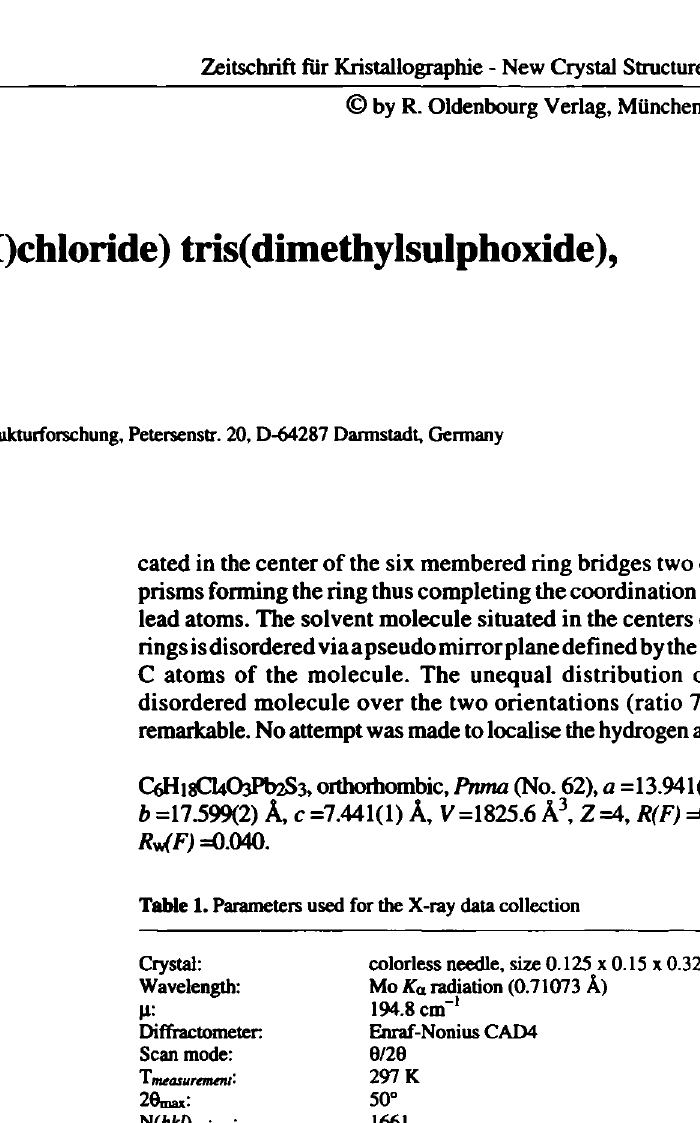
Table 1. Parameters used for the X-ray data collection